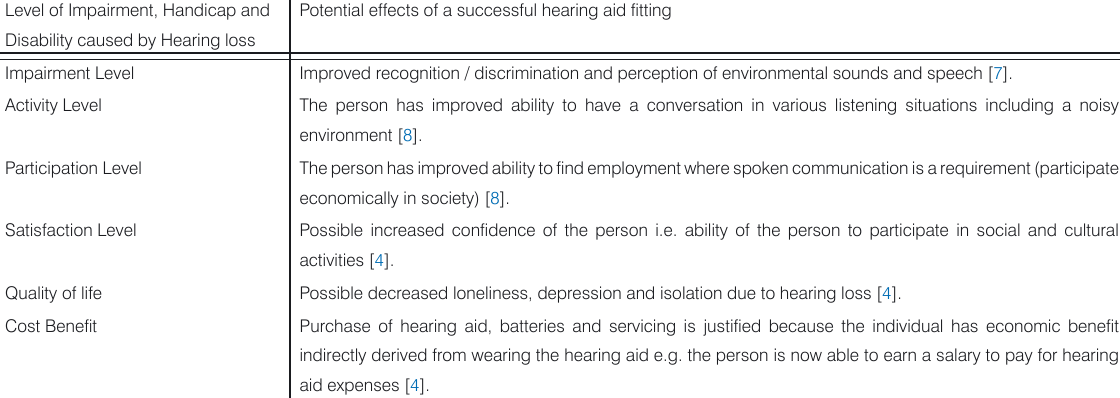
Table 1. Outcomes of Successful Hearing Aid Fitting.